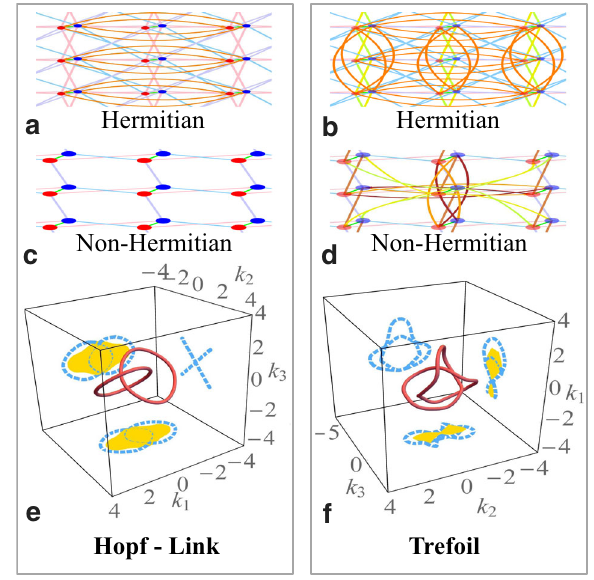
Fig. 1 Comparison of the Hopf link and Trefoil knot nodal knot metals (NKMs). We compare the two simplest nodal knot metals (NKMs) - the Hopf link and the Trefoil knot, constructed from Eqs. (1),(2),(3), with the parameter m set to 2. The former is a (2,2)-torus knot, while the latter is a (2,3)-torus knot. As compared to the Hermitian model ( a , b ), the tight- binding implementation in the Methods shows the enhanced short- rangedness of the non-Hermitian model ( c , d ). The surface state projections ( e , f ) highlight the difference between the usual “ drumhead ” regions demarcated by the surface projections (blue dashed curves) of the bulk nodal lines (red) for the Hermitian case vs. the non-Hermitian topological “ tidal ” states